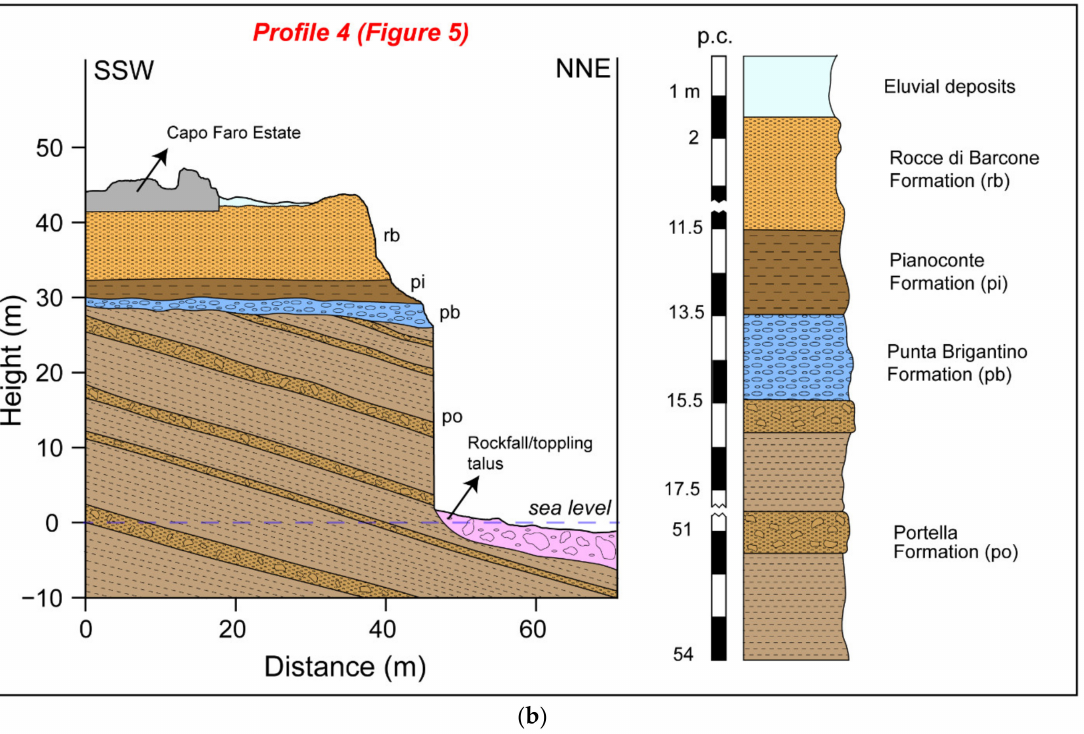
Figure 7. ( a ) Geological cross–section showing the main stratigraphic units (topographic profile 3 in Figure 5); ( b ) Geological cross–section showing the main stratigraphic units (topographic profile 4 in Figure